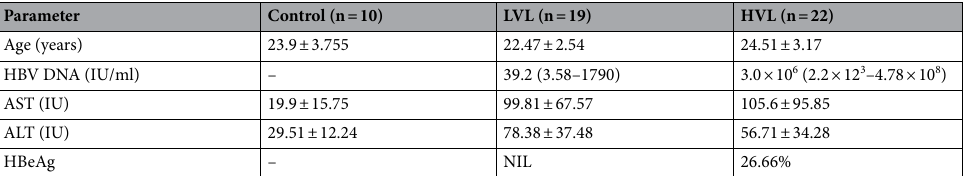
Table 1. Demographic and serological characteristics of study participants: Age, mean ± SD; HBV DNA, median ± range; Aspartate Aminotransferase (AST), mean ± SD; Alanine Aminotransferase (ALT), mean ±